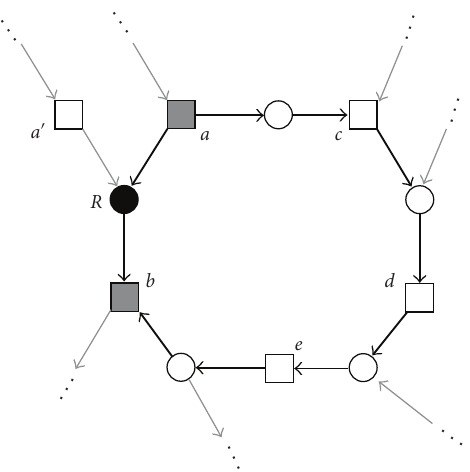
Figure 1: Bipartite graph representation of a reaction network, with circles (resp. squares) denoting reactions (resp. metabolites). Here, reaction R uses metabolites a and a (cid:3) as substrates to produce metabolite b . If R is removed, the conversion of a to b is still permitted by the alternative pathway a → c → d → e → b . When R is fictitiously reversed, this chain forms a directed loop of length 5 reactions, formed by R and by a path passing through (cid:2) = 4 other